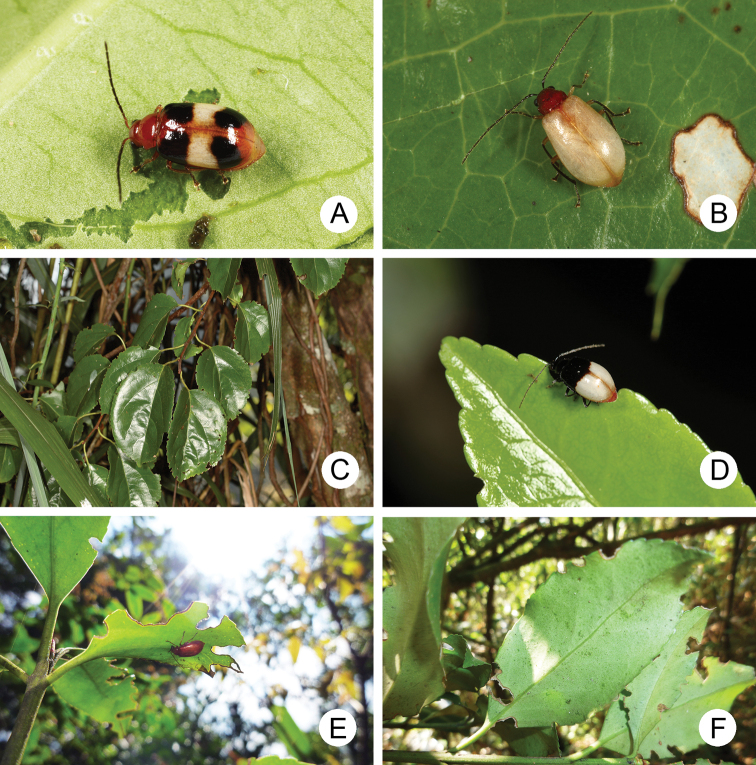
Habitat photographs A adult of Neochya
chengi sp. nov. feeding on leaves of Celastrus
hindsiiB adult of N.
hirashimaiCCelastrus
kusanoi, food plant for Neochya species D adult of N.
nitidissima feeding on leaves of Euonymus
spragueiE adult of N.
tsoui resting on underside of leaves of Euonymus
spragueiFEuonymus
spraguei, food plant for Neochya species.